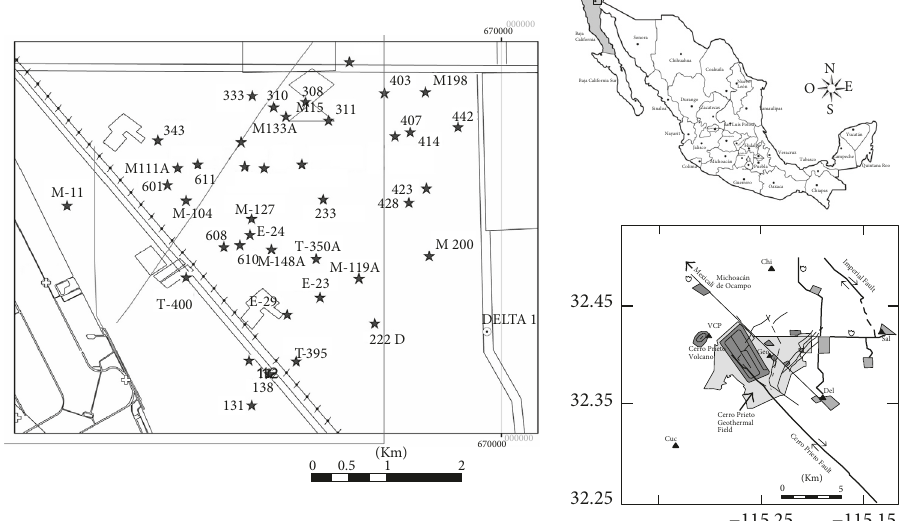
Figure 1: Localization of Cerro Prieto Geothermal Field and sampled